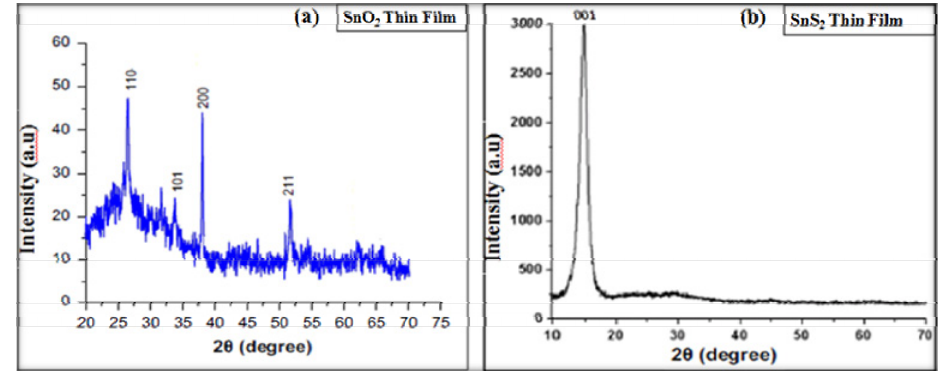
Fig. 1. XRD Pattern of a) SnO Fig 1: XRD Pattern of a) SnO 2 and b) SnS 2 thin films